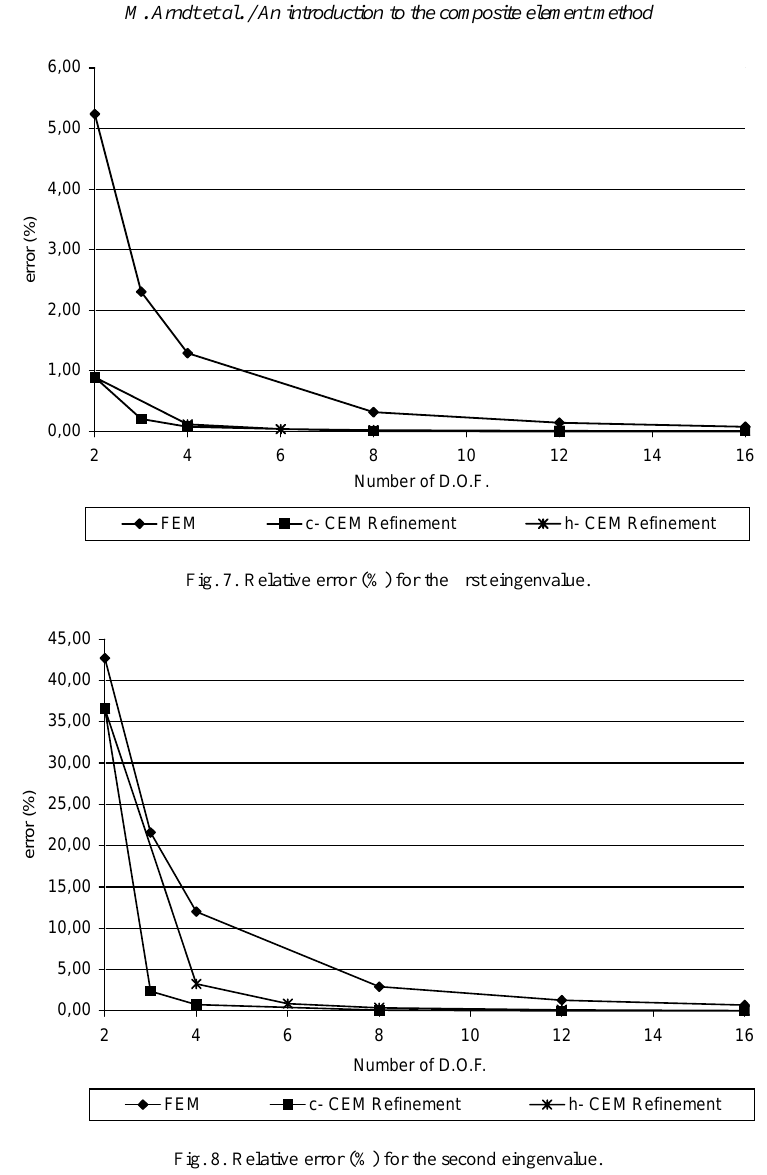
Fig. 8. Relative error (%) for the second